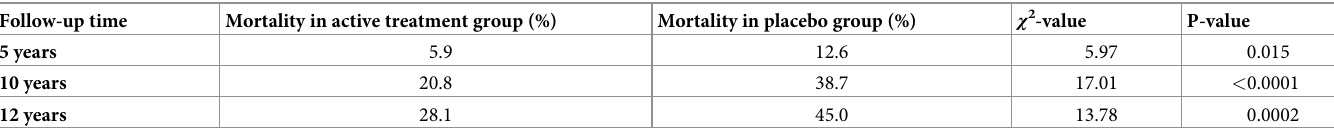
Table 4. Difference in cardiovascular mortality within 5, 10 and 12 years after intervention of selenium and coenzyme Q10 combined or placebo for four years. Follow-up time